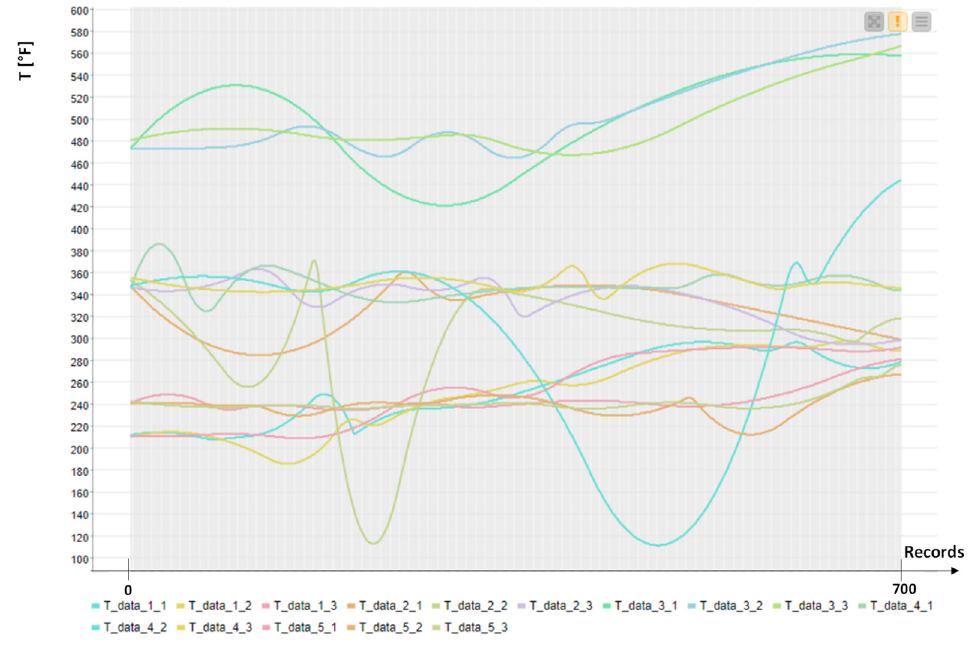
Figure 4. Temperature trends: first 700 records (sorted in time) extracted from the open dataset [23]. The sampling time is 1